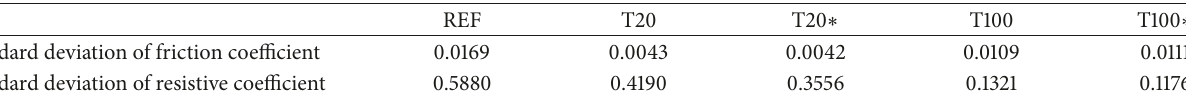
Table 2: Average values of standard deviation of friction coefficient and resistive coefficient for experiments. T20 and T100 represent the valuesofstandarddeviationforthereducedsetofexperiments.T20 ∗ andT100 ∗ representthevaluesofstandarddeviationforallexperiments, without reduction in the number of